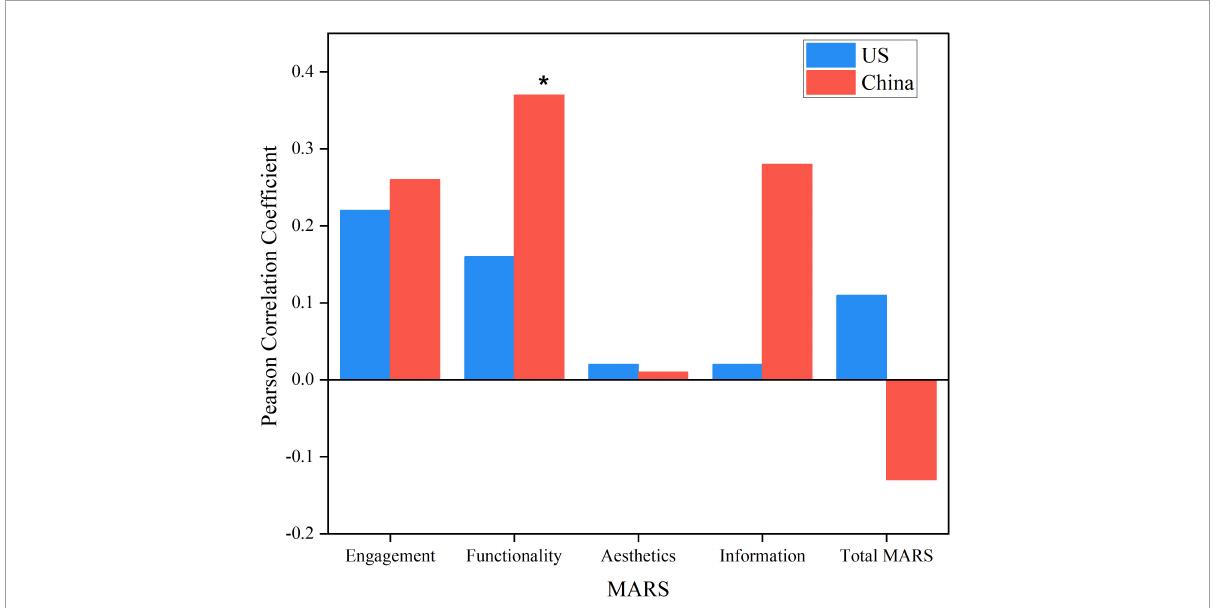
FIGURE5 The bar chart illustrates the Pearson coefficients between Chinese and United States mobile app quality rating, four dimensions rating of app quality, and user rating. The Pearson coefficients’ maximum positive and negative limits are indicated above and below the origin line at zero. * p <